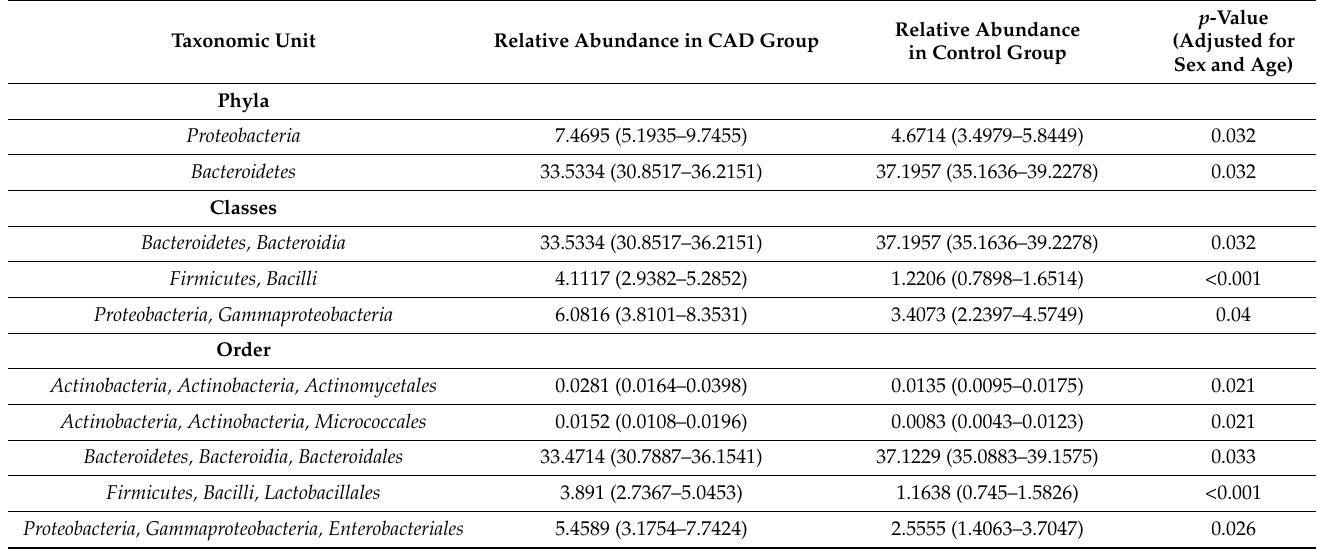
Table 4. Statistically significant differences in relative abundance of bacterial phyla, classes, and orders in studied populations. Taxonomic